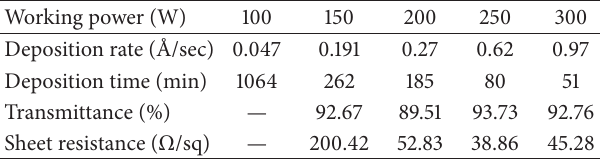
Table 2: Deposition parameters of the AZO